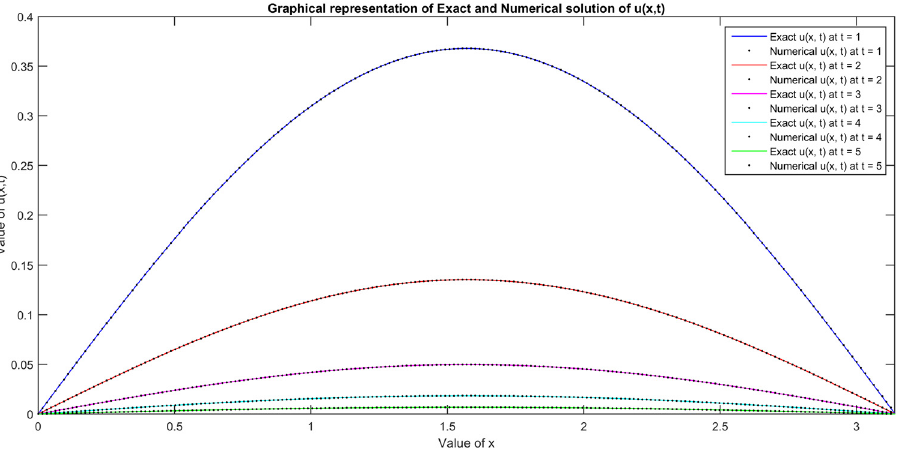
Figure 2: Graphical plot for ( ) u x t , at t = 1, 2, 3, 4, and 5 for N = 201, α = 10, β = 5, t Δ = 0.0001, = τ 0.5 using Method II regarding Example 1.